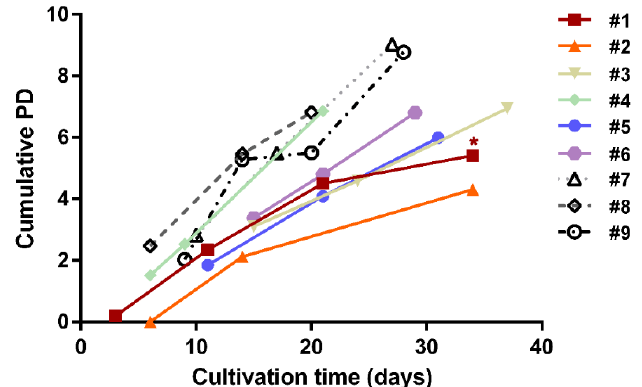
Figure 2. Growth curve of hBM-MSC and hAT-MSC expansion in culture showing cumulative population doubling (PD) between successive passages before experimental analysis. Donor #1 cells showed late-stage slow growth (* p < 0.05).